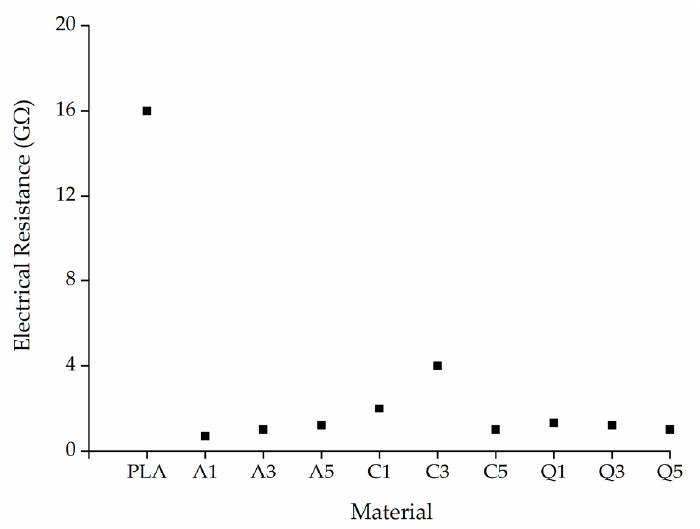
Figure 16. Electrical resistance of PLA and its composites containing 1%, 3%, or 5% ( w / w ) of alizarin (A1, A3, A5), curcumin (C1, C3, C5), or quercetin (Q1, Q3, Q5).